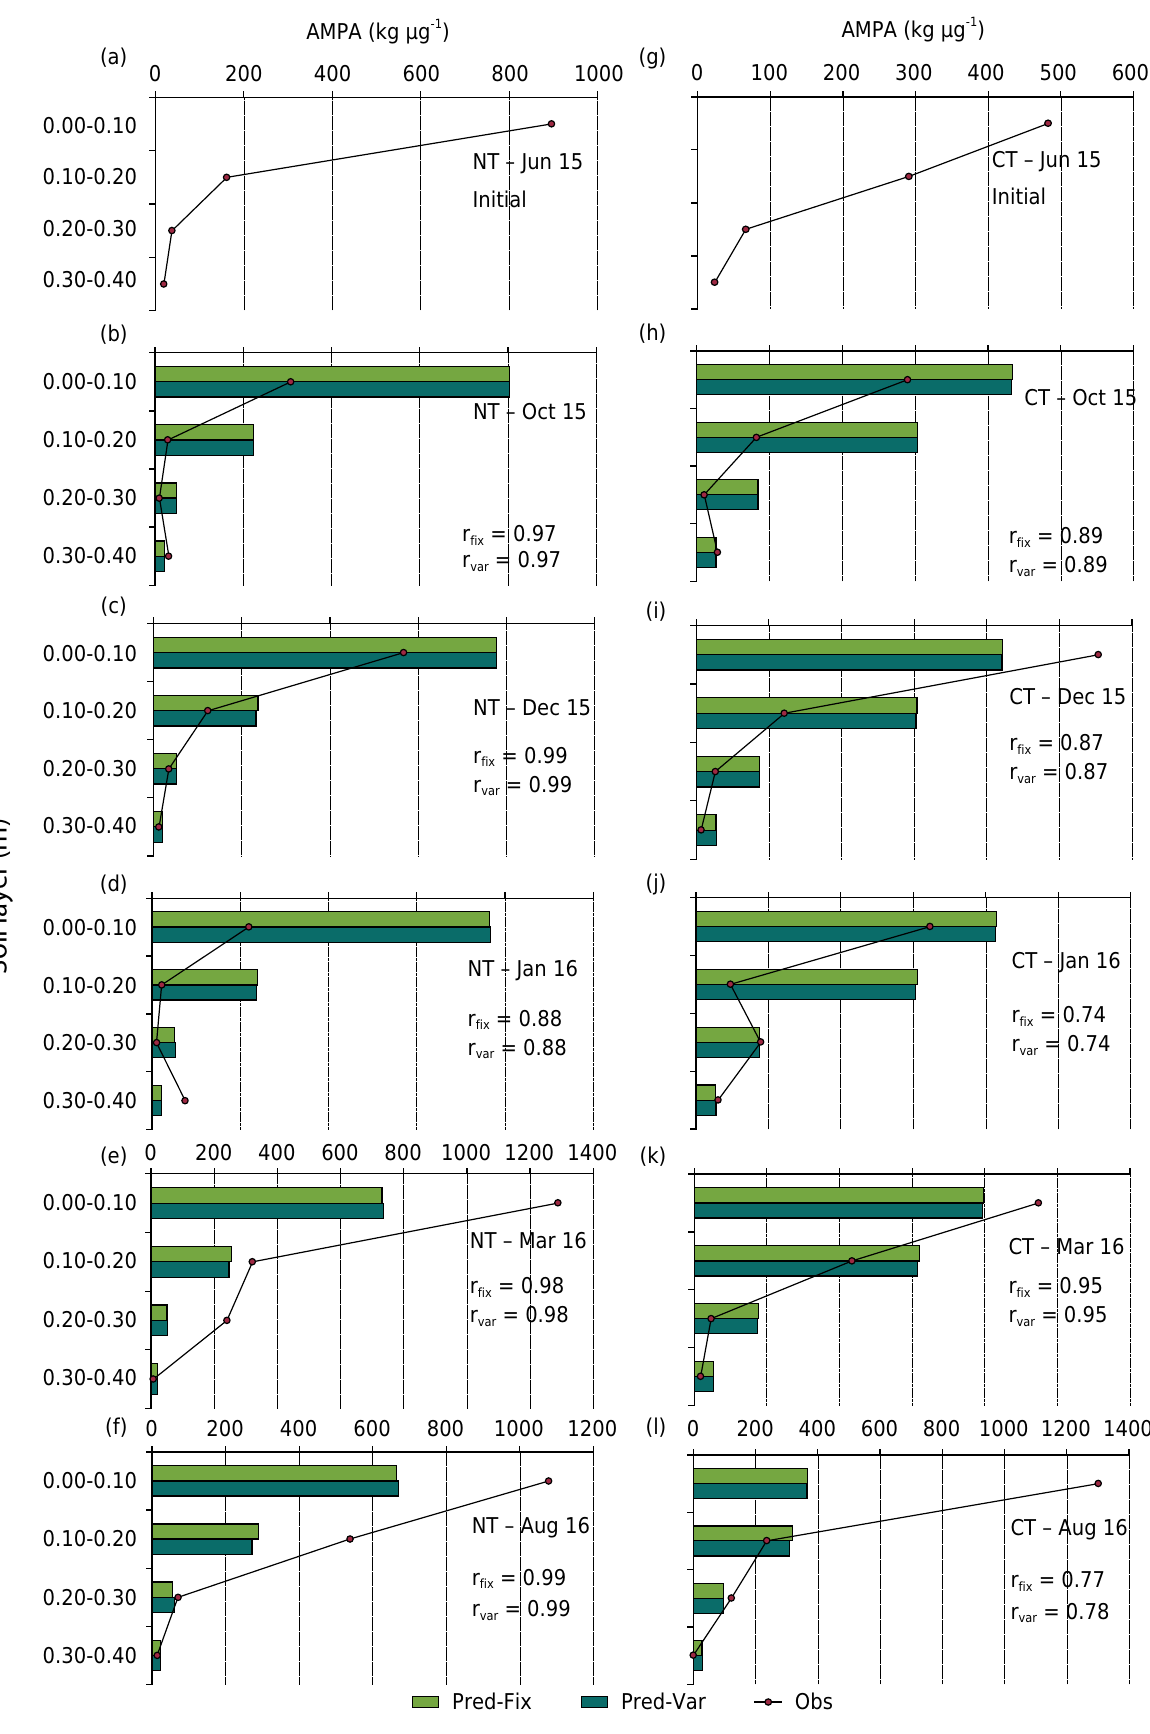
Figure 3. Observed (line) and simulated (bars) vertical AMPA distribution during the crop cycle for no-tillage (NT) and conventional tillage (CT) using constant (Pred-fix) and time variable (Pred-var) hydraulic parameters. Tillage operation for CT treatment was carried out on September 30th,